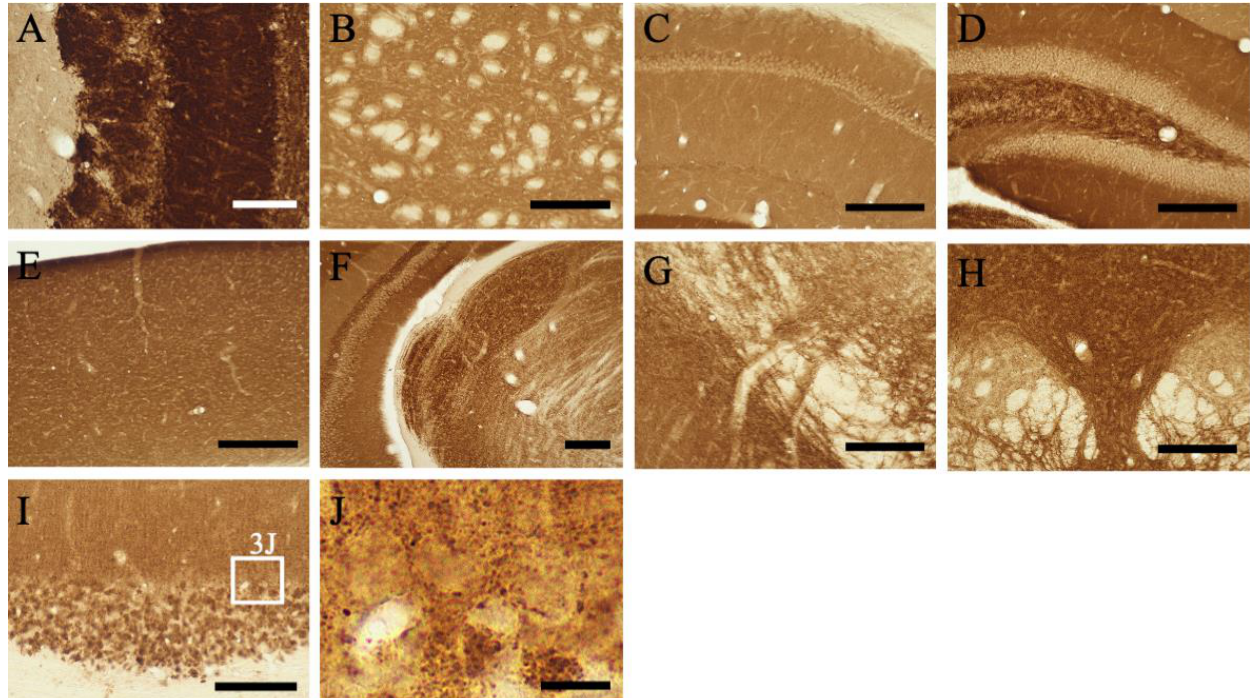
Figure 3. ( A – I ) Higher magnification views of the MGRN1 immunoreactivity shown in Figure 2 are displayed. ( J ) A higher magnification view of the white box in ( I ). The white boxes indicate the positions of the high magnification image in ( J ). The scale bars in ( A , I ) = 100 μm, ( B – H ) = 200 μm, and ( J ) = 10 μm, respectively.